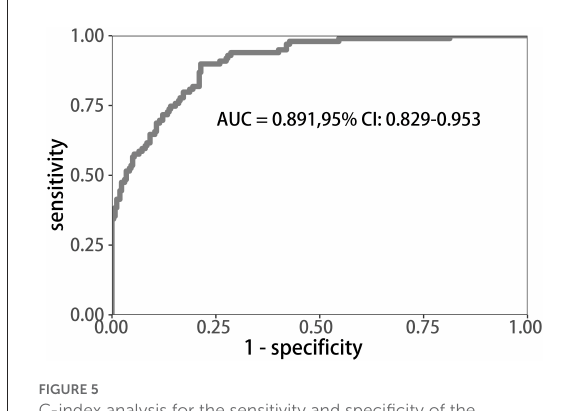
FIGURE5 C-index analysis for the sensitivity and specificity of the nomogram.